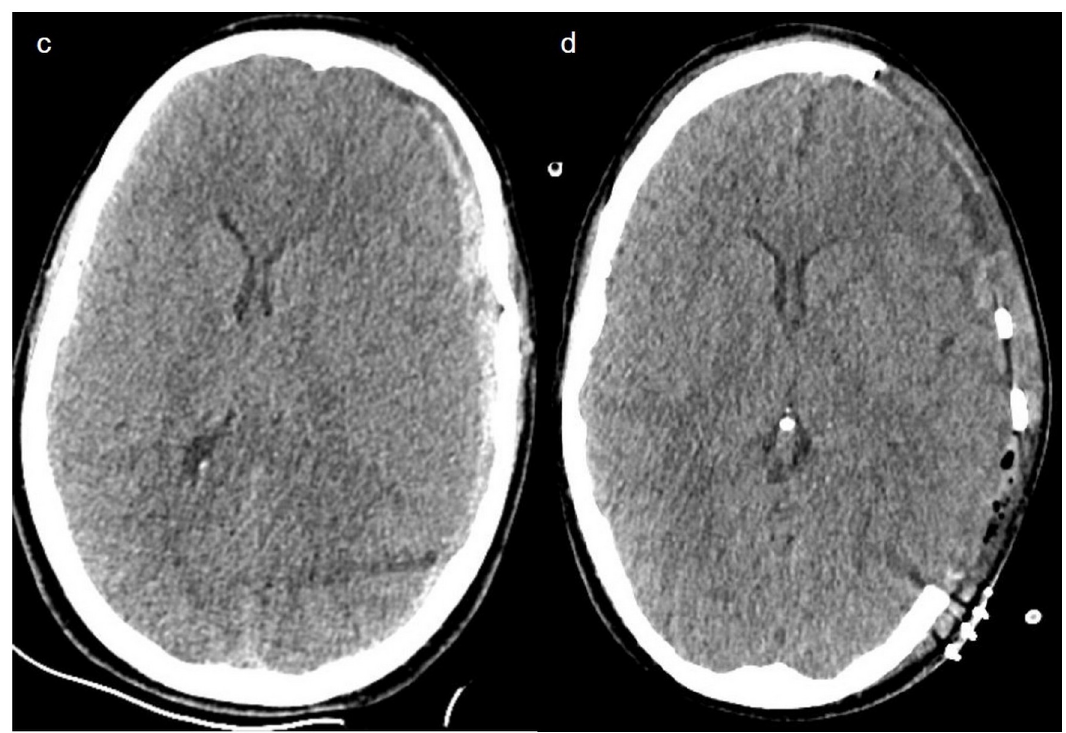
Fig 3. Case illustration. Patient 2. A 39-year-old female patient after a skiing accident with head trauma. The GCS at rescue team arrival was 12 points, with a rapid decrease to GCS of 5 points and development of a left anisocoria c) In the CT scan, we observe an acute subdural hematoma with an important midline shift. She underwent a decompressive hemicraniectomy and left hospital 2 weeks later with a GCS of 15. d) Postoperative CT